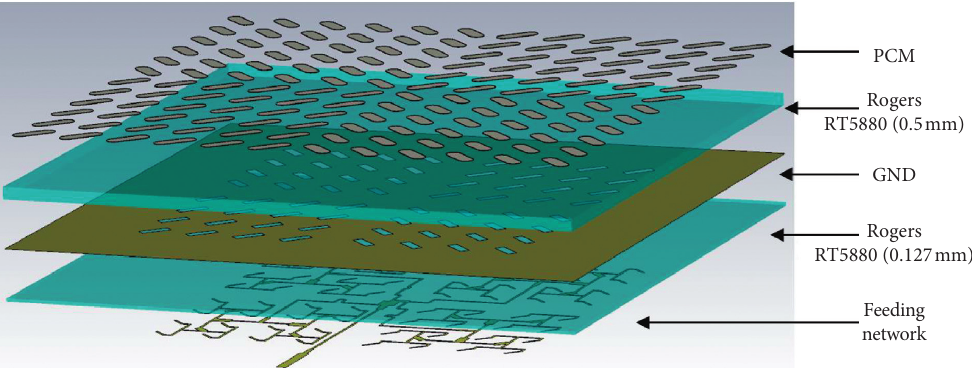
Figure 8: Structure of slot antenna array with RCS